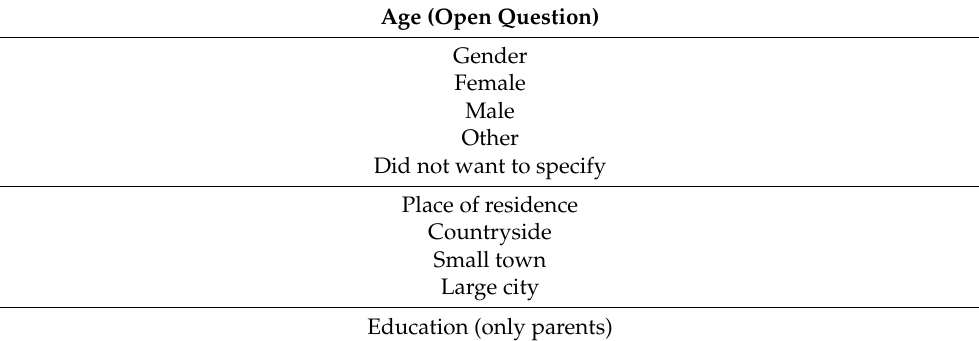
Table 3. Questionnaire